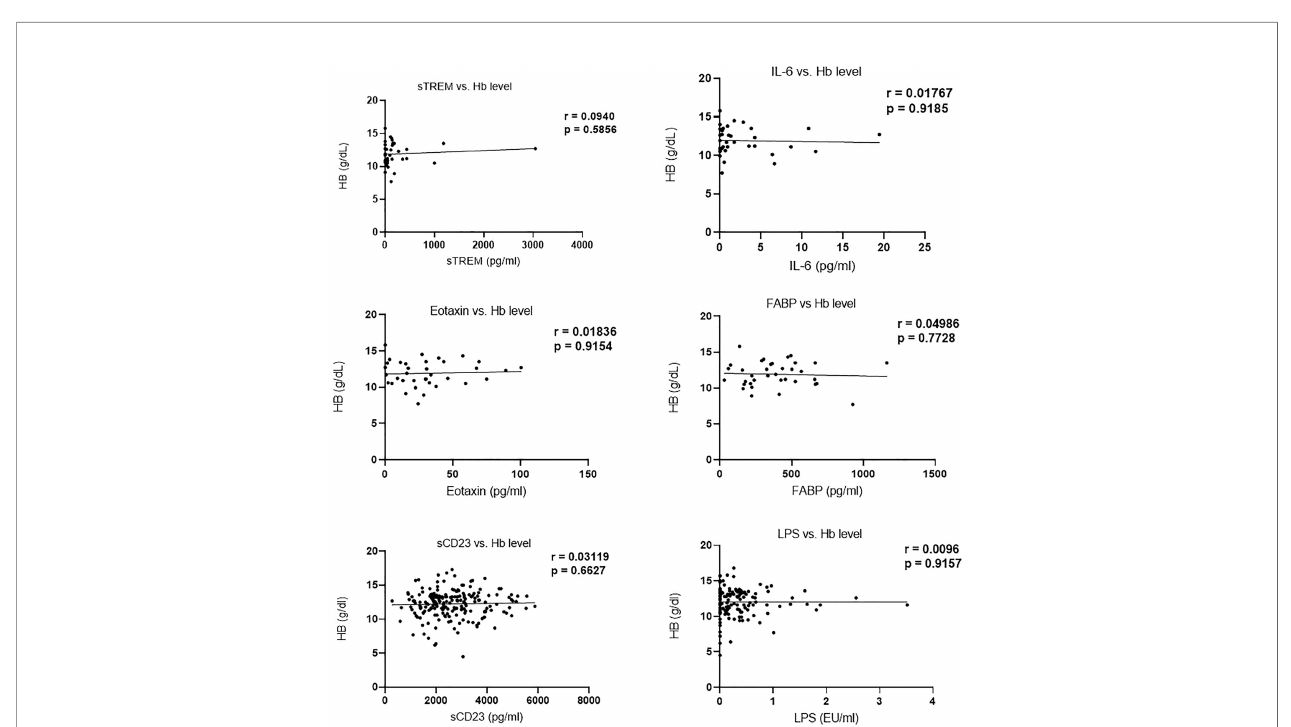
FIGURE 4 | Correlation of biomarker concentration and hemoglobin (g/dl) levels among study